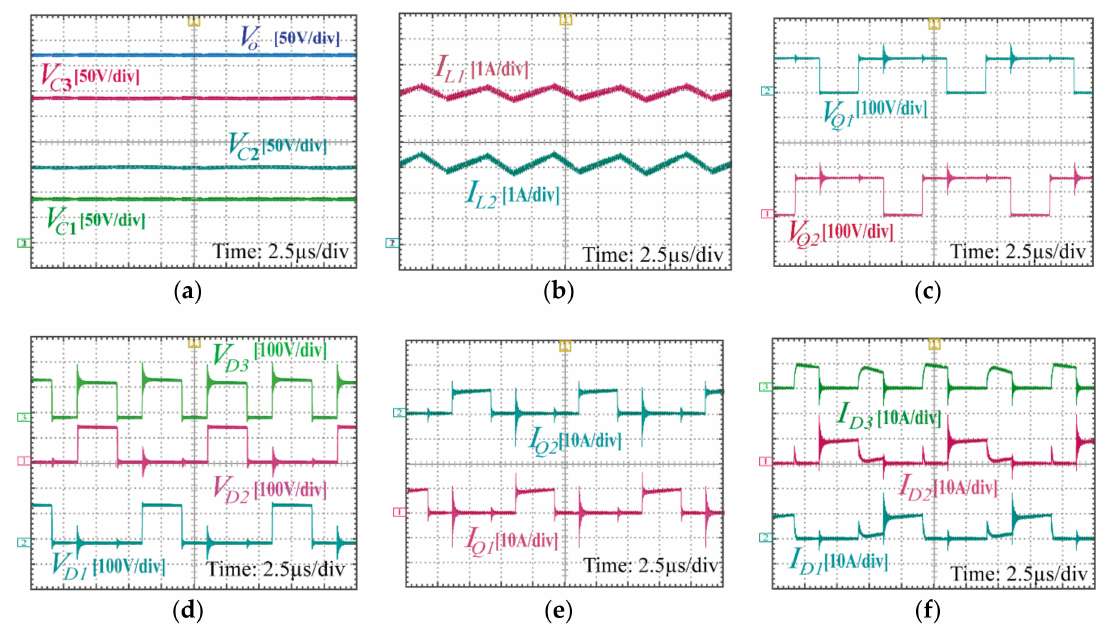
Figure 8. Experimental results when V in = 200 V, D = 0.3, R L = 120 Ω , P out = 1.15 kW.